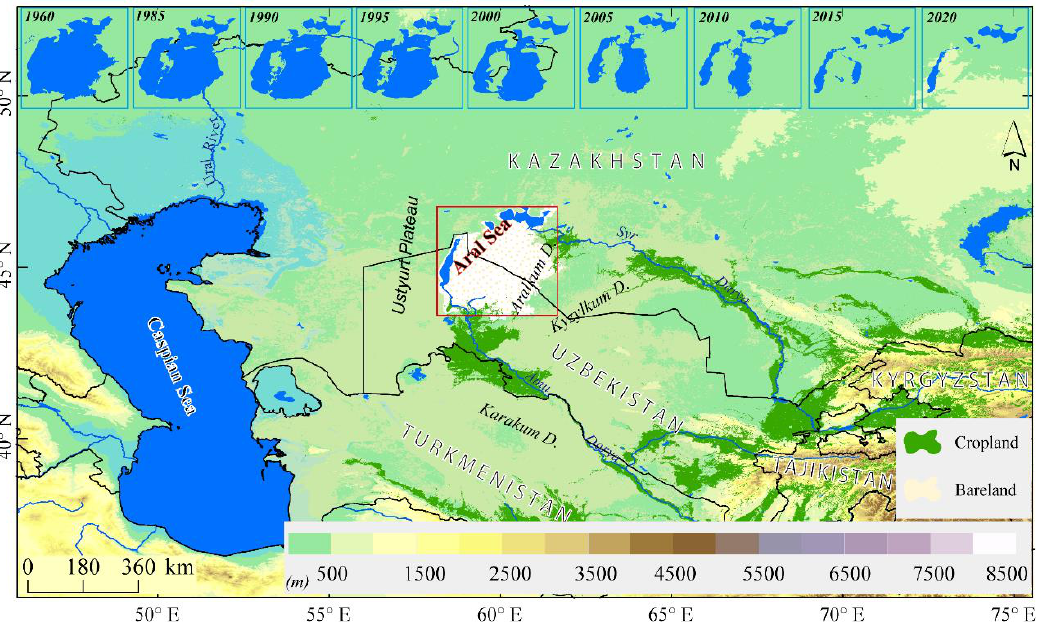
Figure 1. Geographic location of the Aral Sea in arid Central Asia and the change in area of the Aral Sea from 1960 to 2020. The annual area of the Aral Sea was derived from Landsat data; the cropland and bareland were extracted from the Global ESA CCI land cover classification map in 2020, with a spatial resolution of 300 m.